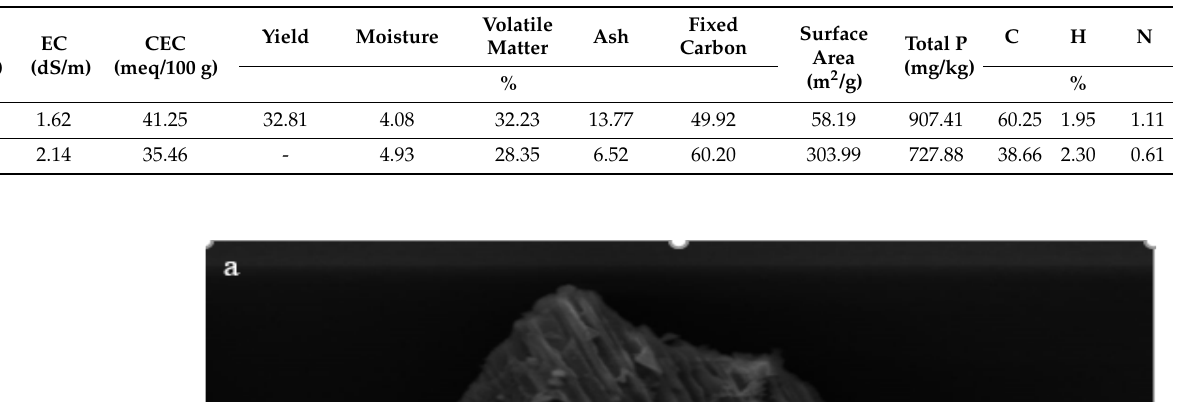
Table 2. Properties of Biochar (BC) and Acidified Biochar (ABC).